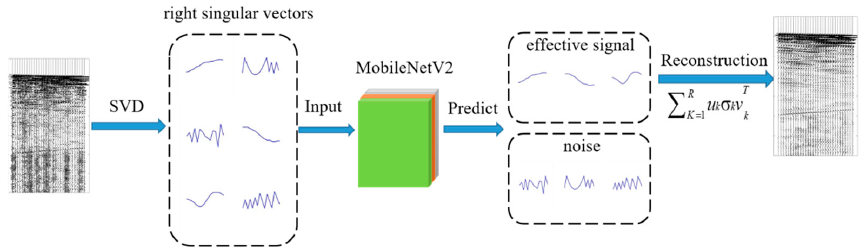
Figure 2. Improved SVD process for seismic data.